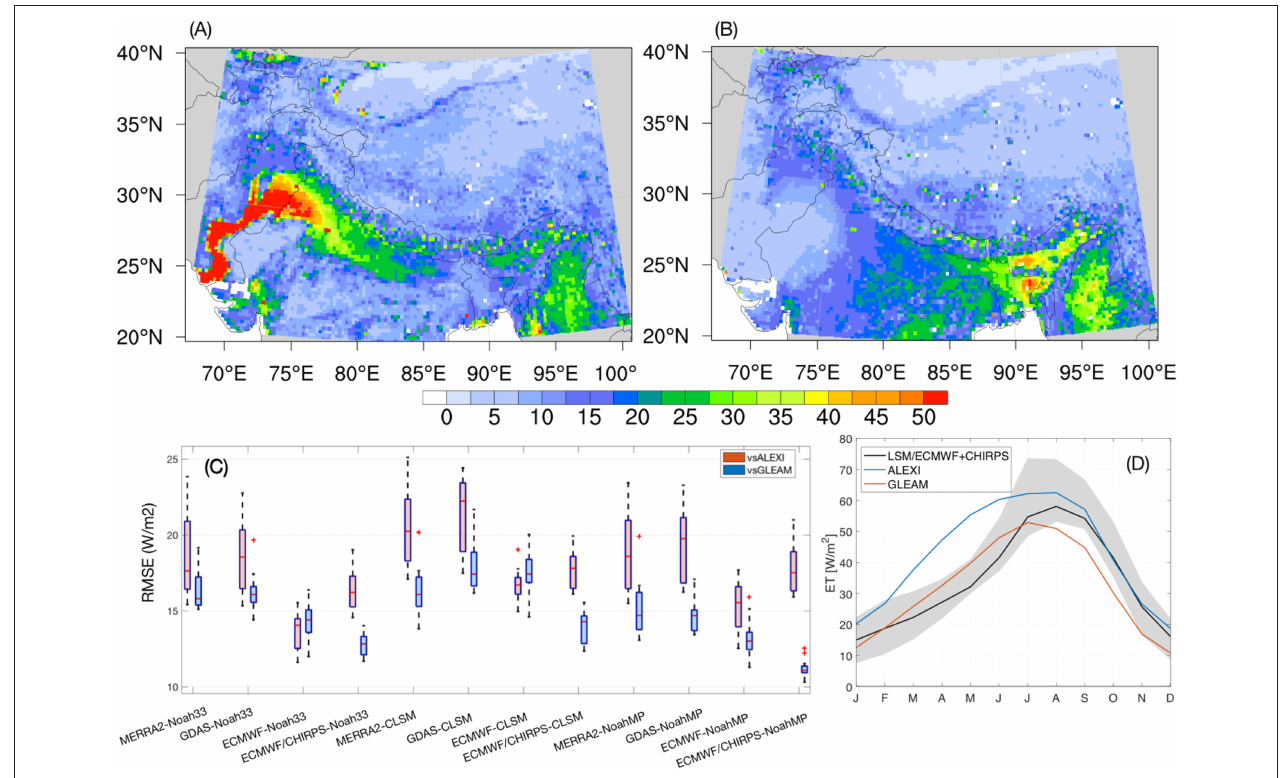
FIGURE 11 | Maps of ensemble mean RMSE ( W / m 2 ) of ET across the 12 ensemble members compared against ALEXI (A) and GLEAM (B) , distribution of the domain-averaged RMSE from each of the 12 LSM runs (C) and the mean seasonal cycle of ET (D) . The gray shading in (D) represents the spread in ET across the LSMs.